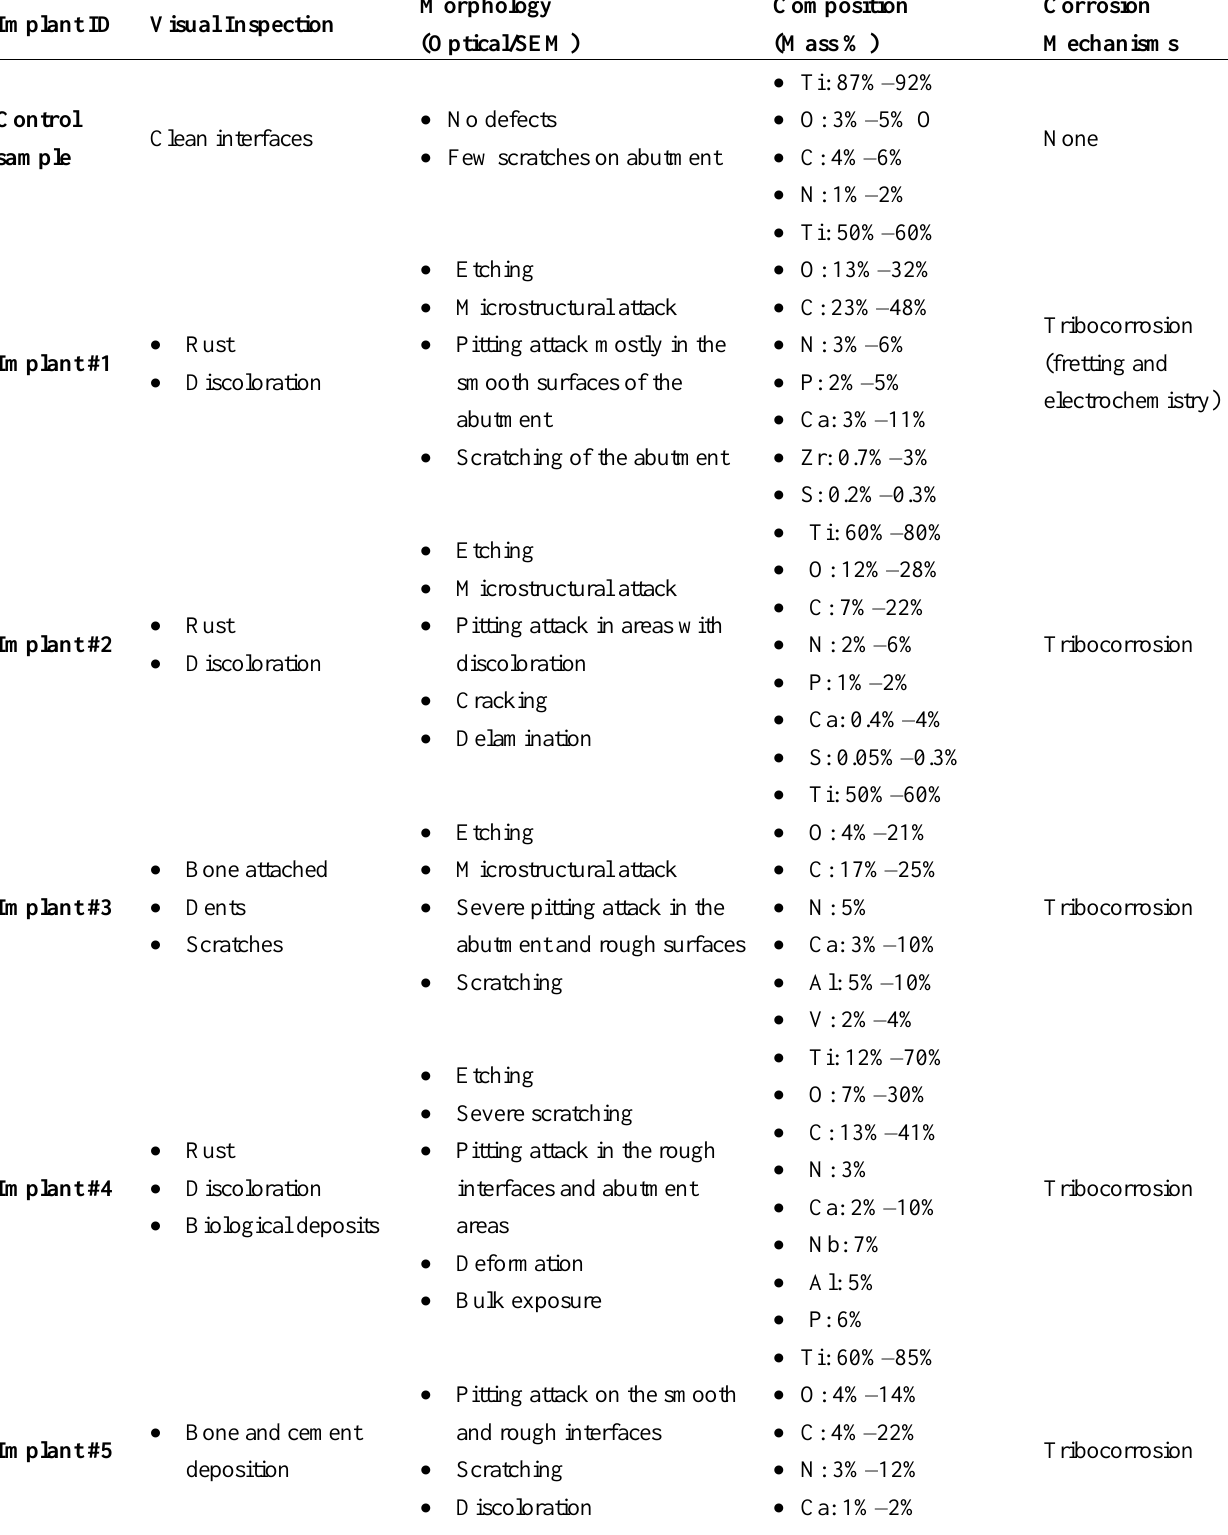
Table 2. Summary of events observed on the surface of the retrieved titanium dental